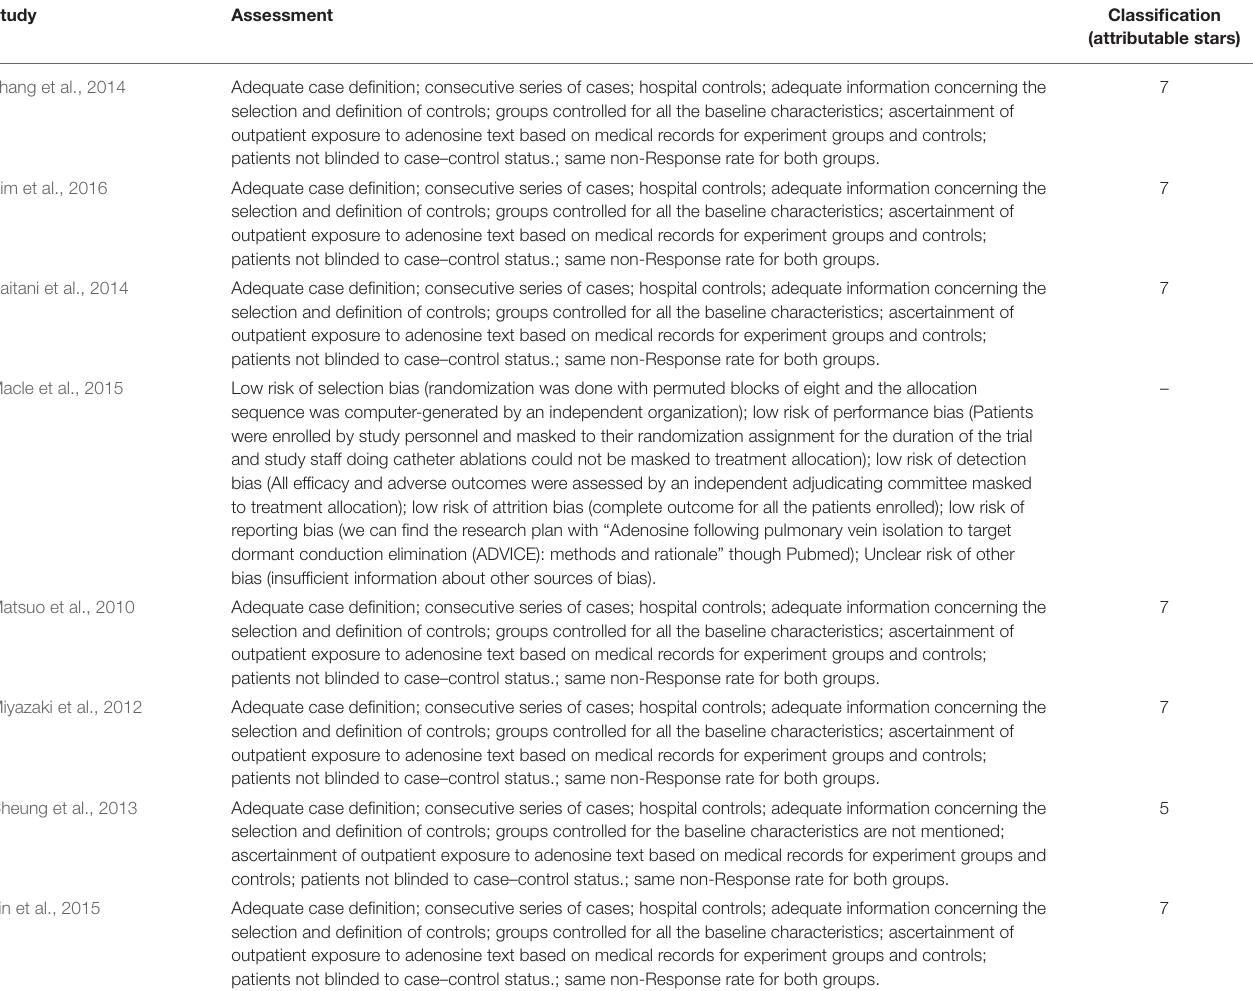
TABLE 3B | Assessment of the quality of included studies in Group DC ( + ) and Group DC ( − )*.